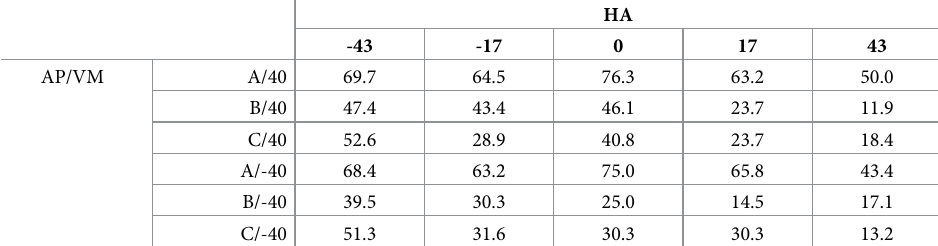
Table 3. Percentage of participants that judged each movement as won a game in Experiment